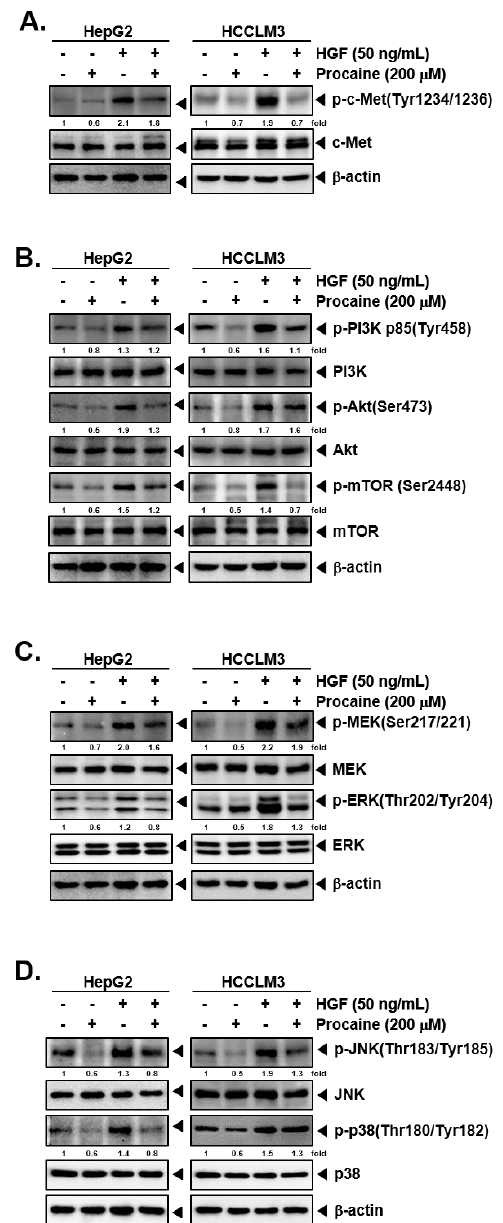
Figure 3. Influence of procaine on c-Met regulated signalling cascades. ( A – D ) HepG2 and HCCLM3 cells were pre-treated with procaine (200 µ M) for 6 h, exposed to HGF (50 ng/mL) for 30 min, and subjected to western